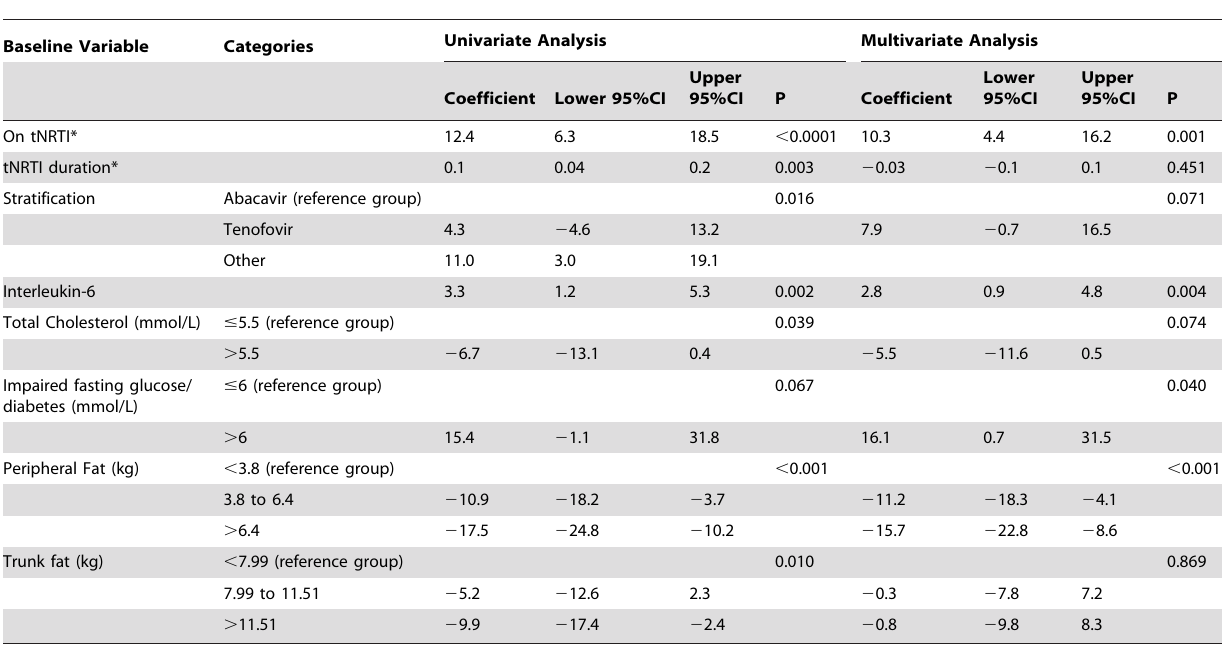
Table 3. Baseline covariates assessed in the multivariate model of percent change in peripheral limb fat mass at 96 weeks for HIV participants randomised to ABC-3TC or TDF-FTC